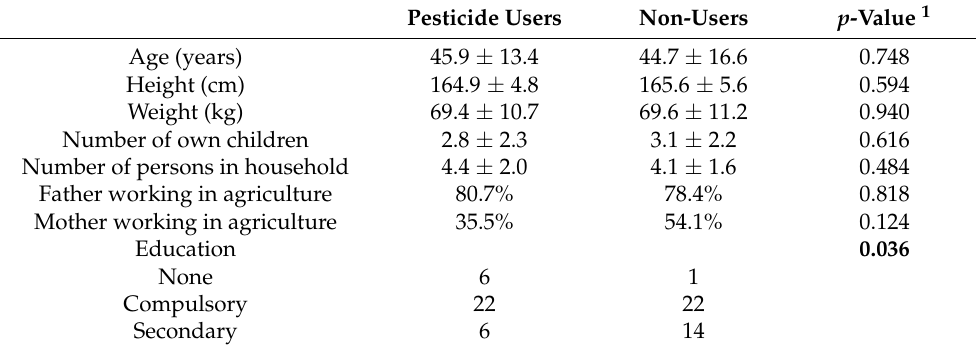
Table 2. Socio-demographic and anthropometric data by pesticide